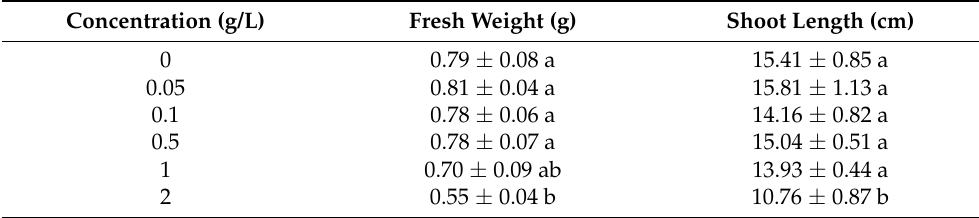
Table 1. The effects of dihydrocoumarin on rice seedling growth.